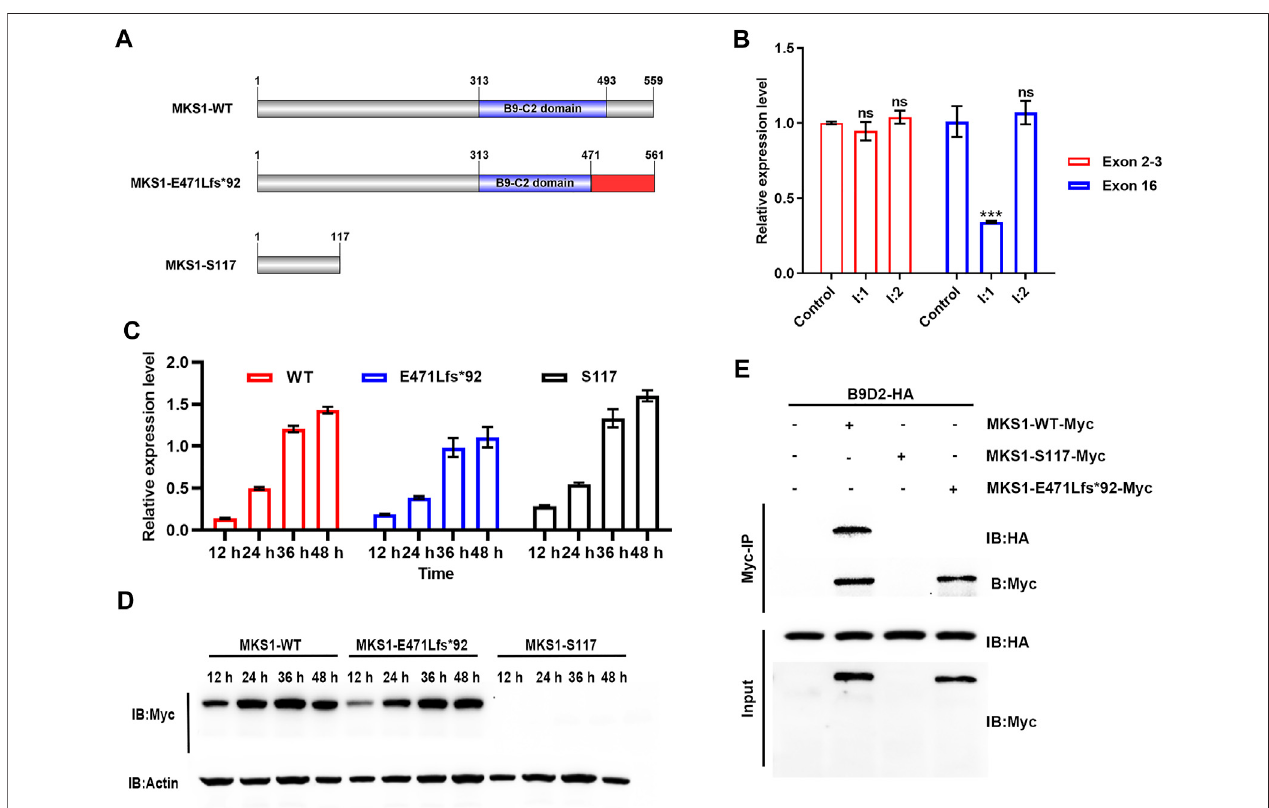
FIGURE3 | MKS1 mutantslose the interaction with B9D2 protein. (A) Schematic ofthe MKS1 proteins (wild-type, E471Lfs*92, S117). The red rectangle indicates the frameshifted sequence of MKS1 p.E471Lfs*92. (B) Relative MKS1 mRNA levels of the individuals (I:1 and I:2) compared to the healthy control. (C) Relative MKS1 mRNA levels of 293T cells transfected with Myc-tagged MKS1 CDS shown in (A) for 12, 24, 36, and 48 h. Data from three independent experiments were used for quanti fi cation. Error bars represent mean ± SD. Statistical signi fi cance was determined by unpaired Student ’ s t -test. ns: nonsense. *** p < 0.001. (D) Immunoblot analysis of 293T cells shown in (C) , implying the expression of wild-type and frameshifted MKS1 with the absence of MKS1 p.S117*. (E) Immunoprecipitation of Myc- tagged MKS1 variants with B9D2. The pull-down of B9D2 with the Myc bead demonstrated the function of the B9-C2 domain of MKS1 proteins.